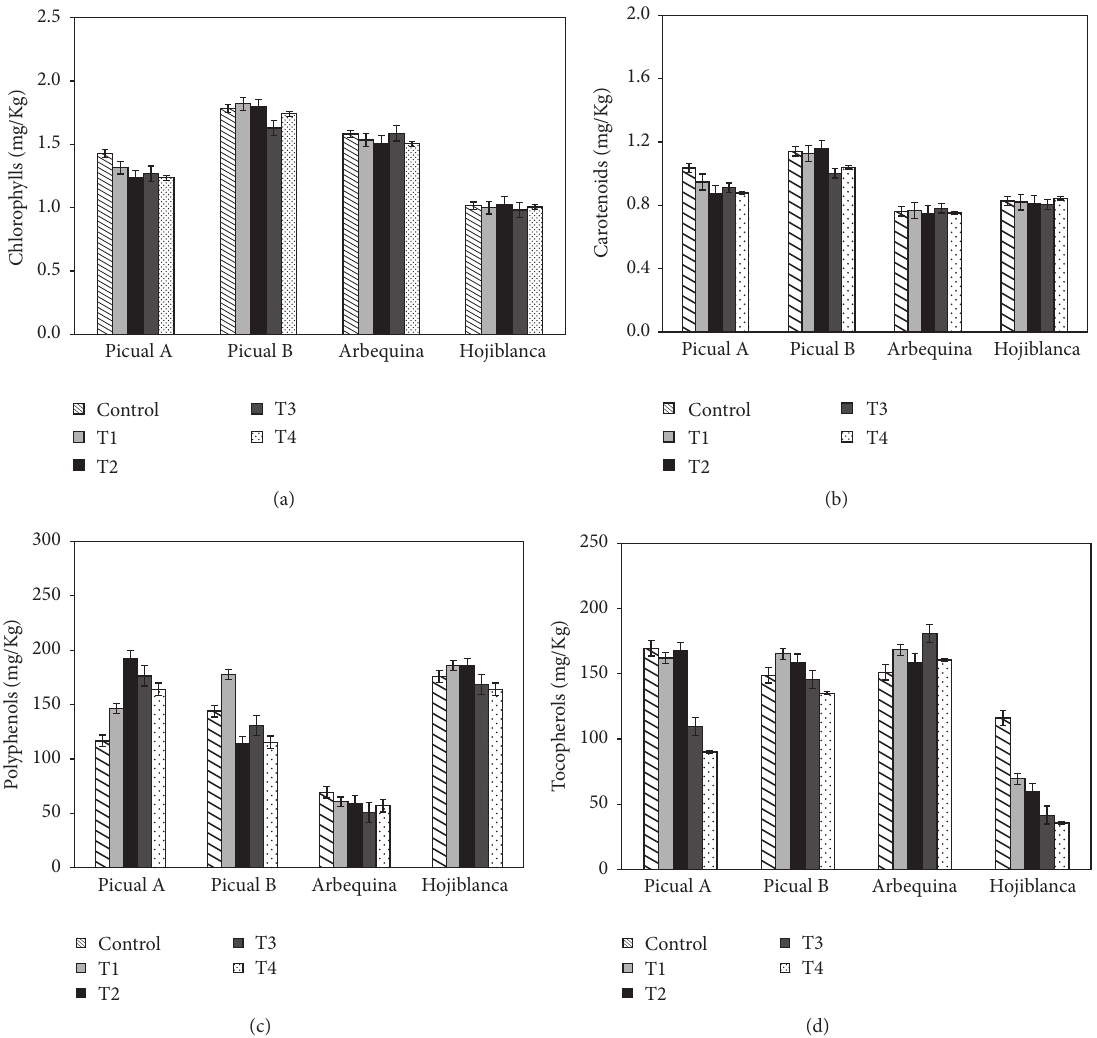
Figure 5: Influence of the heating treatments on the minority compounds: (a) chlorophylls, (b) carotenoids, (c) phenols, and (d) tocopherols.